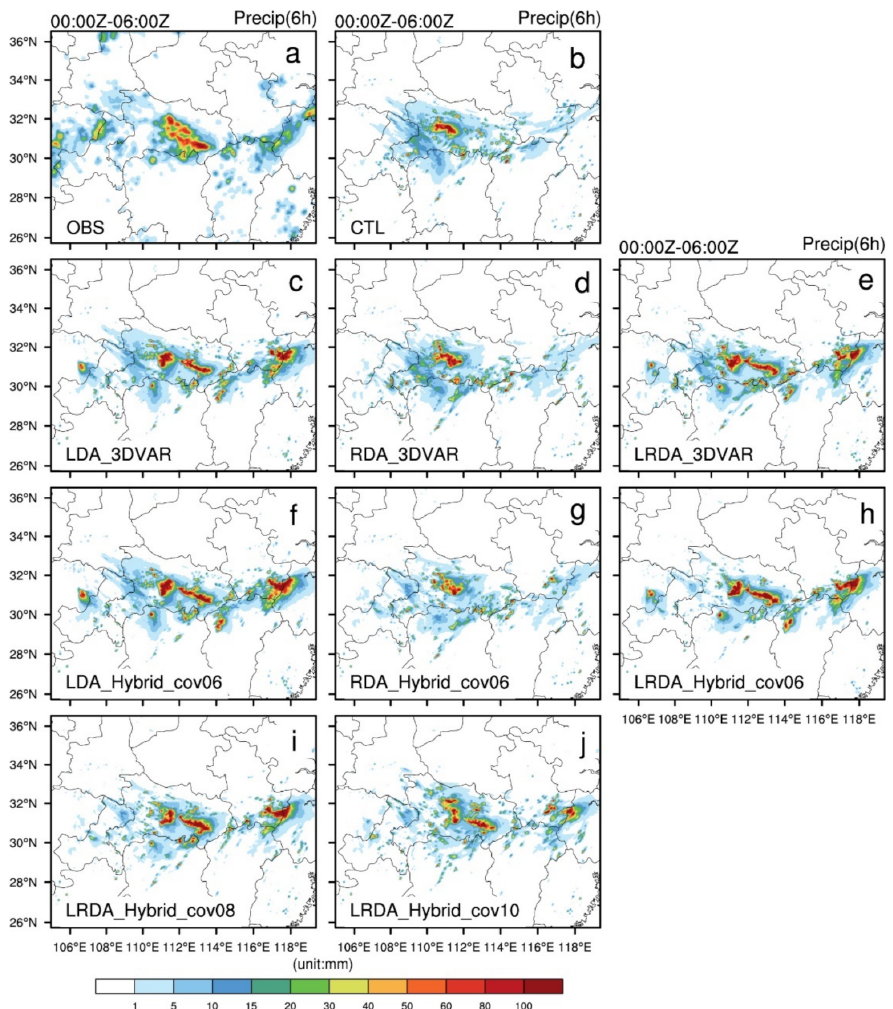
Figure 8. The observed and forecasted 6 h accumulated precipitation for single-analysis experiments from 0000 UTC to 0600 UTC on 30 June 2018. ( a ) Observed precipitation (OBS), ( b ) control run (CTL), lightning ( c , f ), radar ( d , g ) and the combined lightning and radar data assimilation ( e , h ) by 3DVAR ( c – e ) and hybrid 3DEnVAR ( f – h ) showed that β 1 = 0.4, β 2 = 0.6. The combined lightning and radar data assimilation by hybrid 3DEnVAR ( i , j ) showed that β 1 = 0.2, β 2 = 0.8 and β 1 = 0.0, β 2 = 1.0,